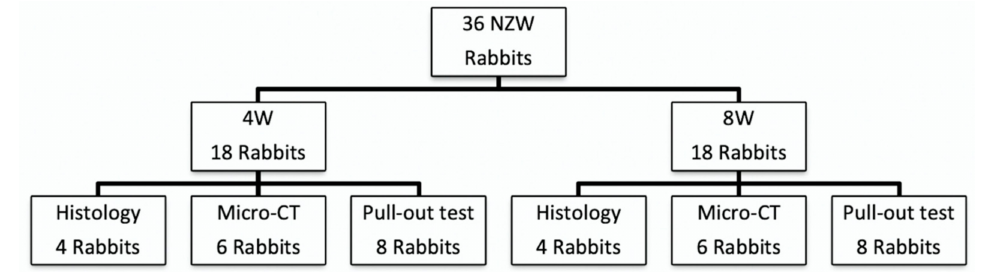
Figure 1. Animal study